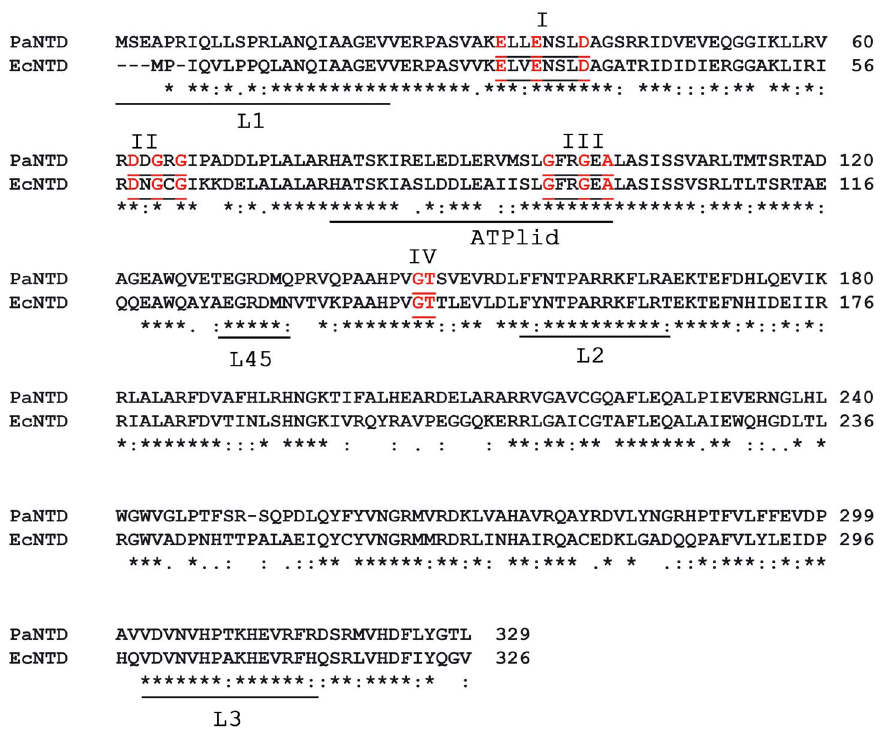
Figure 1. Sequence alignment of MutL PaNTD and EcNTD. ATP binding motifs conserved among GHKL ATPase superfamily (I–IV) are indicated. Red residues correspond to conserved residues within motifs. Loops involved in NTD dimerization (L1, L2, L3 and L45), as well as ATP lid, are indicated with horizontal bars. Amino acids that are identical (*), strongly similar ( : ) or weakly similar ( . ) are indicated.